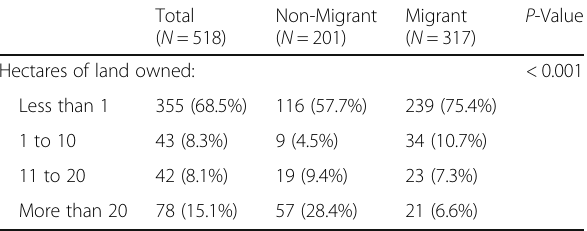
Table 6 Financial capital: Land